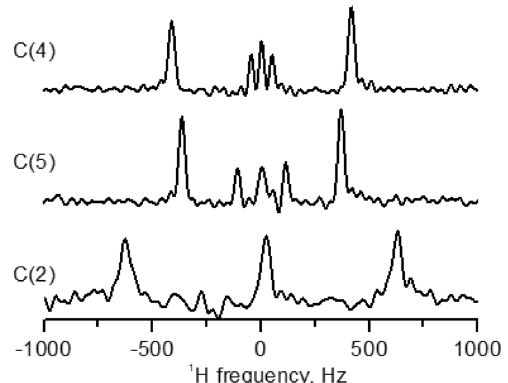
Figure 4. Dipolar cross sections for the carbons in imidazolium ring obtained from 2D PDLF spectrum of C